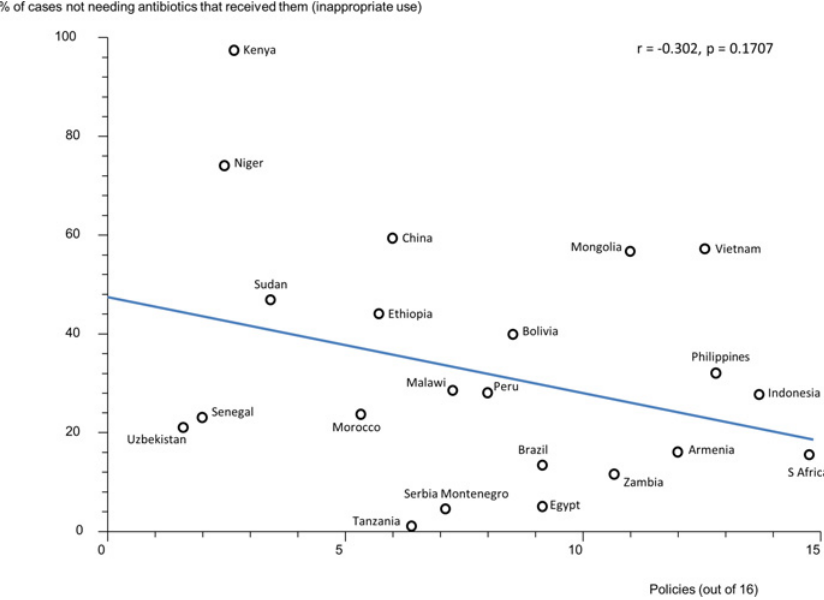
Fig 3. Correlation between the number of implemented policies (out of 16) and the percentage of patients not needing antibiotics who received them. Correlation coefficient (r) = -0.302, p = 0.1707. Each data point (circle) represents a